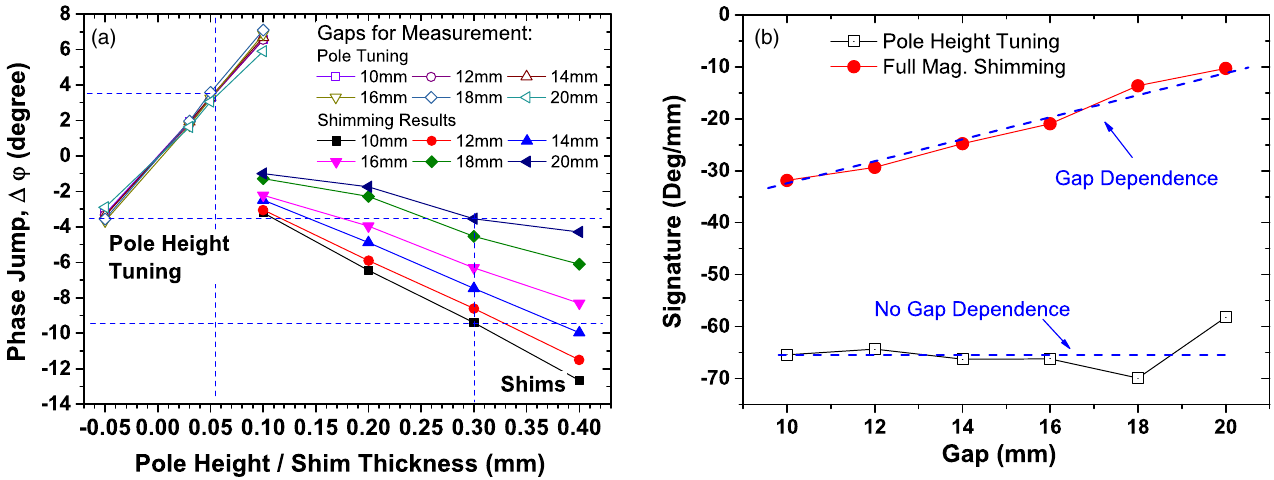
FIG. 9. (a) Gap dependence of phase jumps Δ φ induced by tuning the height of a pair of poles and by shims of different thicknesses. The abscissa shows the amount of pole tuning or shim thickness. The dashed lines should guide the eye for the determination the shimming strengths; see the text. (b) Resulting signatures. For pole height tuning, there is no gap dependence. Note that for direct quantitative comparison the sign of the signature of pole height tuning was reversed. The undulator X014 is used for the measurement.